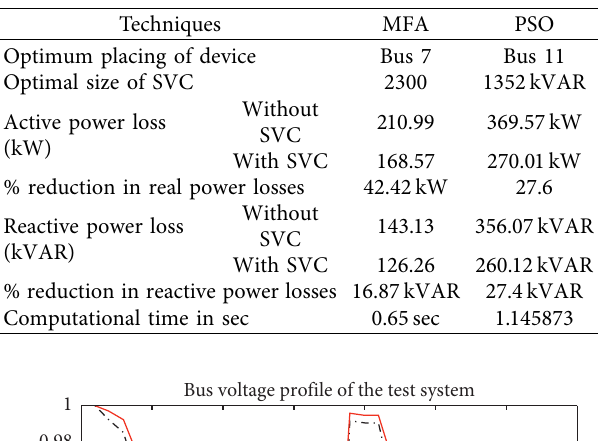
Table 3: Comparison results show location and rating of SVC and power loss reduction in 34-bus system.